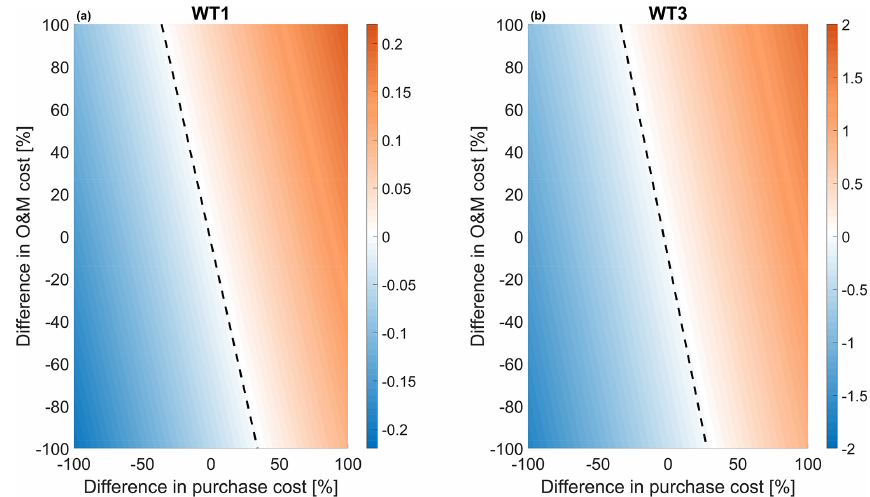
Figure 10. Percent variation of LCOE (shown in the color bars) as a function of purchase and O&M costs of LAC systems for the offshore machine WT1 (a) and the onshore machine WT3 (b)